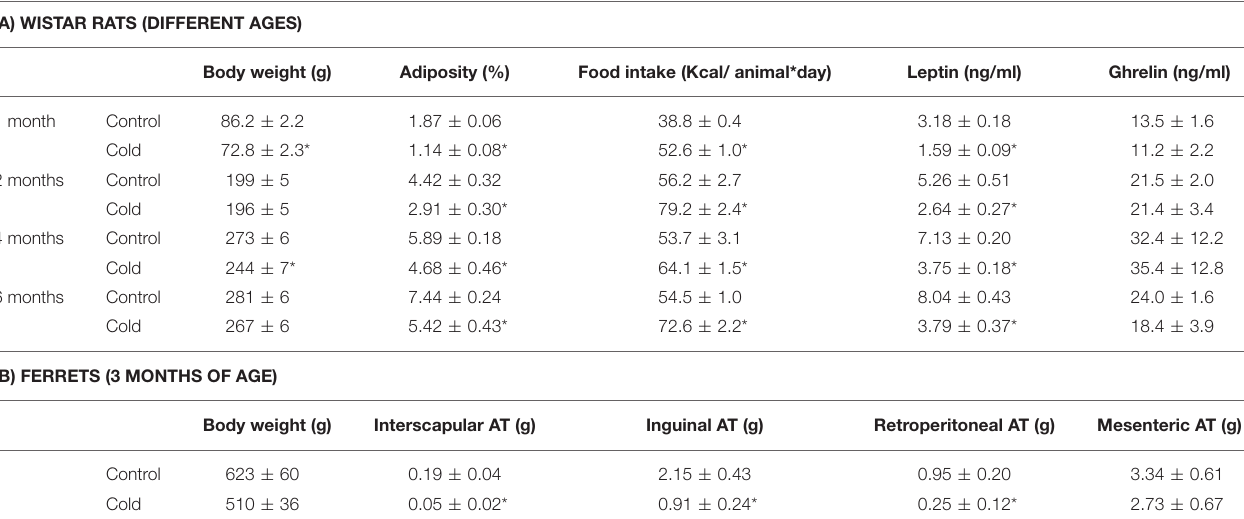
TABLE 2 | Body weight, adiposity, food intake and serum parameters.